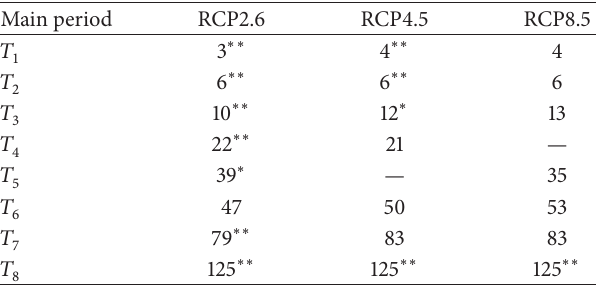
Table 2: Main periods ( 𝑇 ) under the three emission